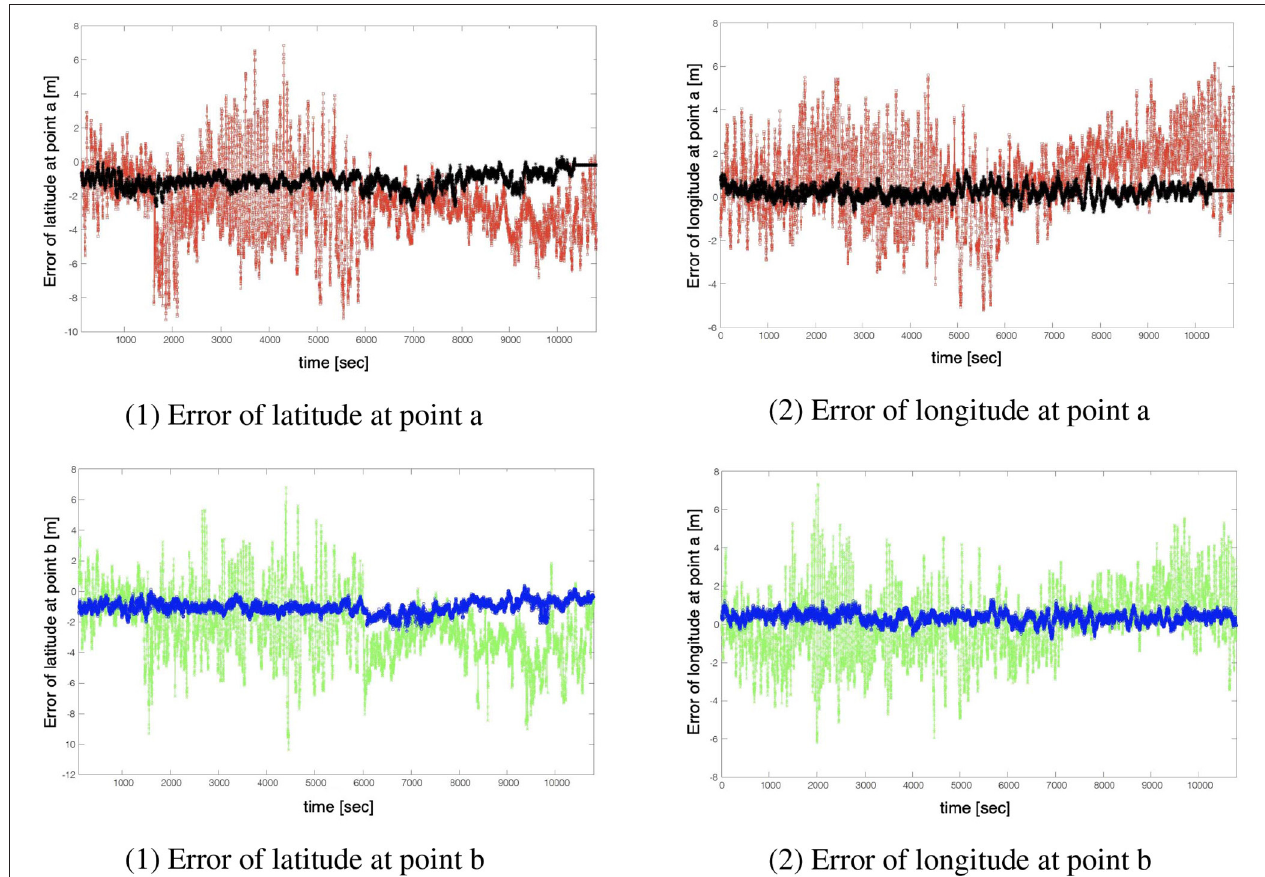
FIGURE 4 | Results at point a and b of pre-experiment 1.